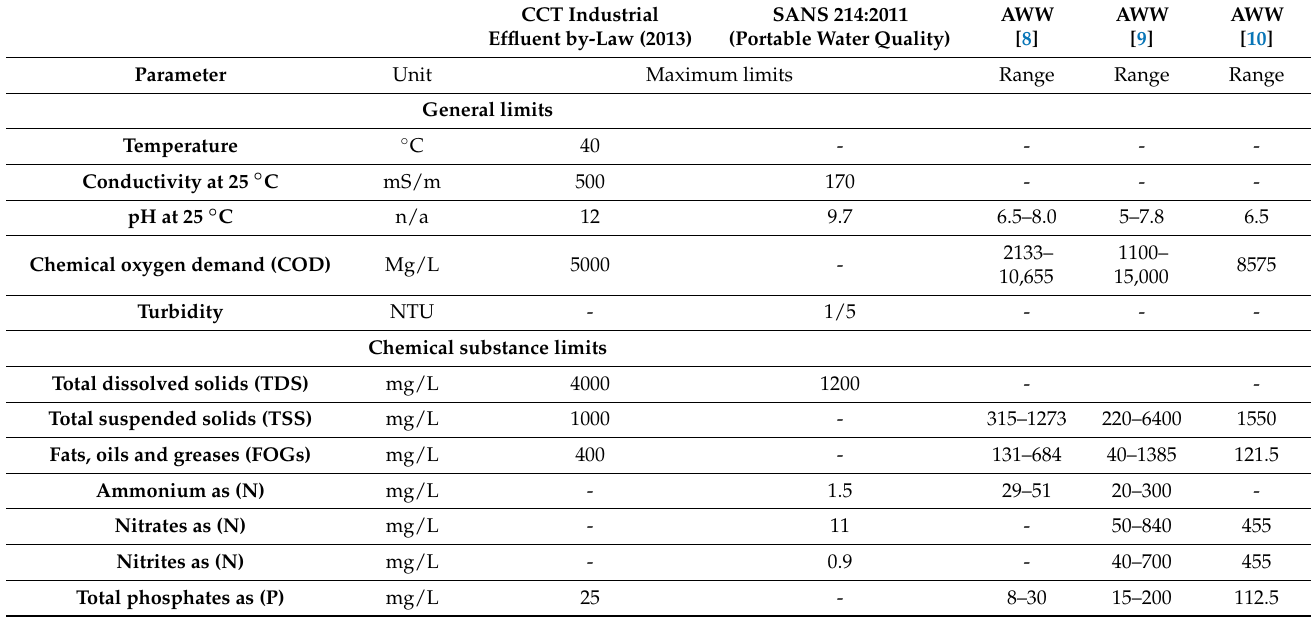
Figure 1. Characteristics of abattoir wastewater [Abbreviations: BOD biological oxygen demand; COD chemical oxygen demand; TOC total organic carbon; TN total nitrogen, P phosphorus; DO dissolved oxygen] [7] . Table 1. Maximum limits permitted by the City of Cape Town: Wastewater and Industrial Effluent By-law 2013 and the characteristics of different abattoir